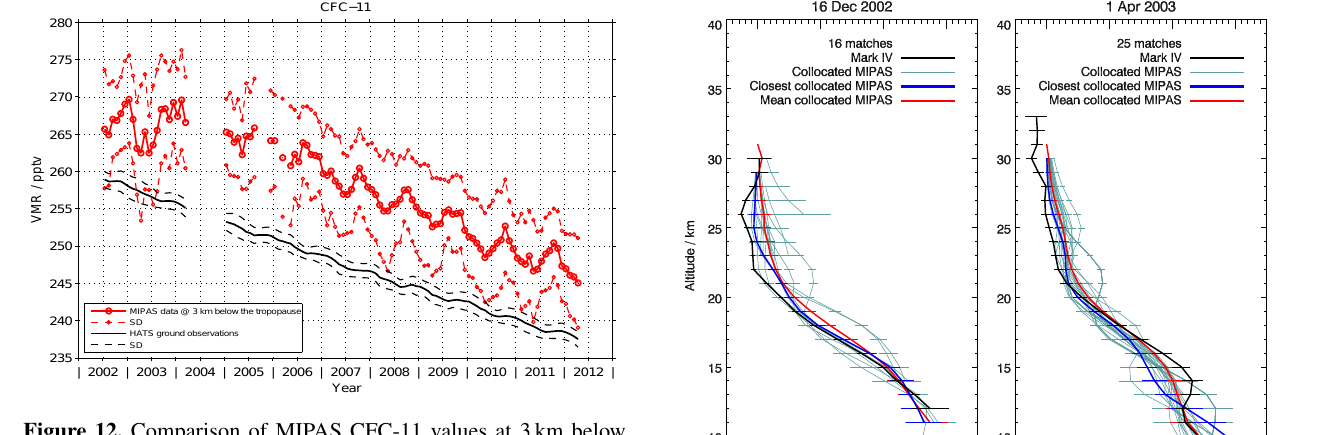
Figure 12. Comparison of MIPAS CFC-11 values at 3km below the tropopause (red) and ground-based measurements of the HATS network (black). Dashed lines denote the standard deviation.